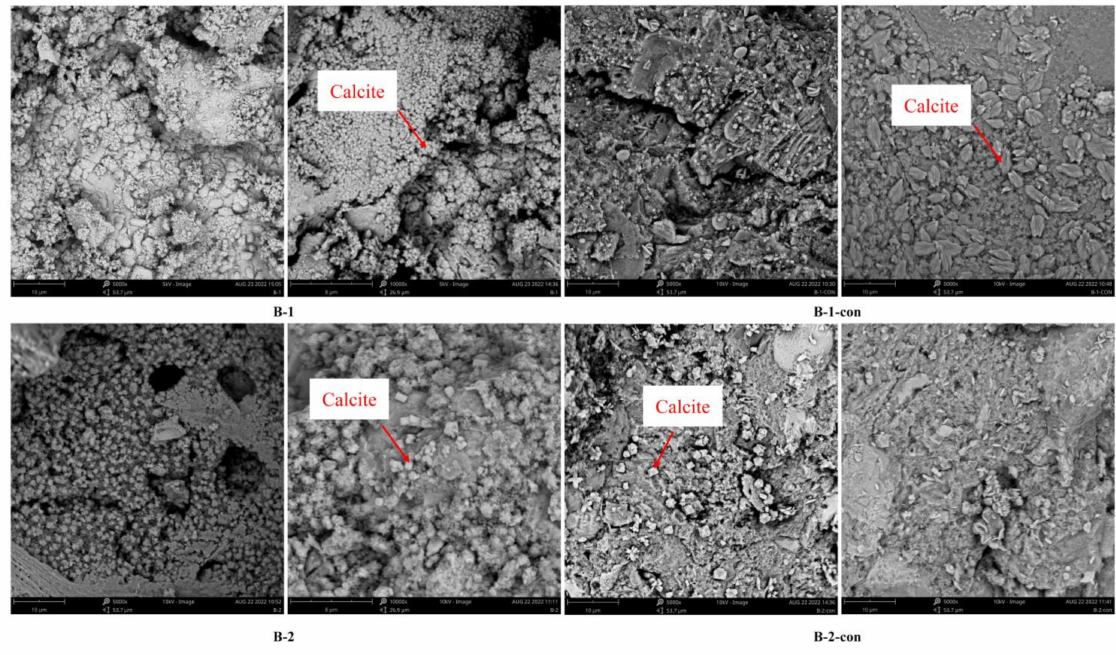
Figure 14. SEM observation in samples of B-1 and B-2